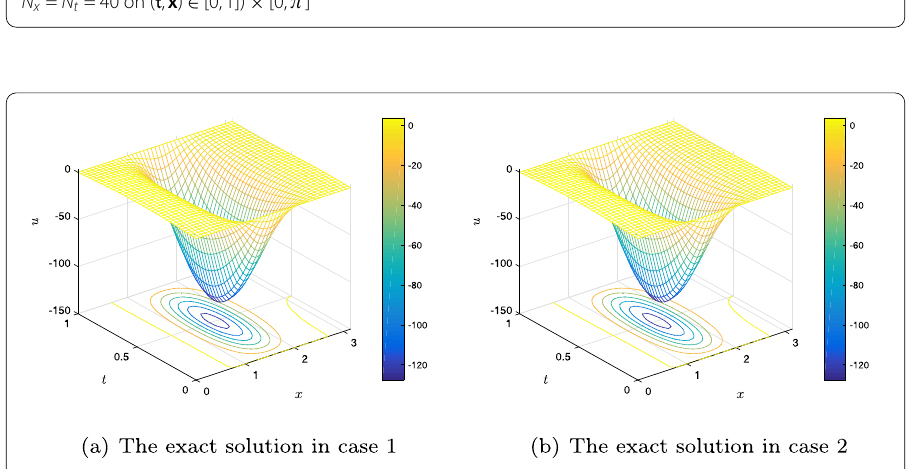
Figure 7 A comparison between the regularized solution in case 1 and case 2 for α = 0.8, δ = 0.001, and